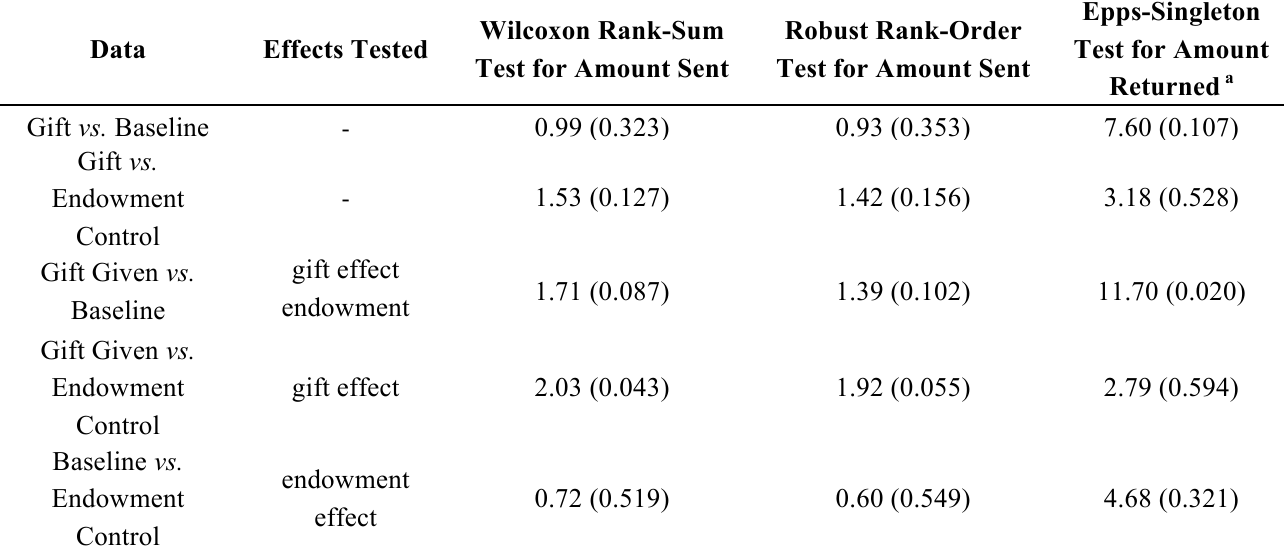
Table 2. Tests for Gift and Endowment Effects on the Amount Sent and Epps-Singleton Test of Distributions of Amount Returned.